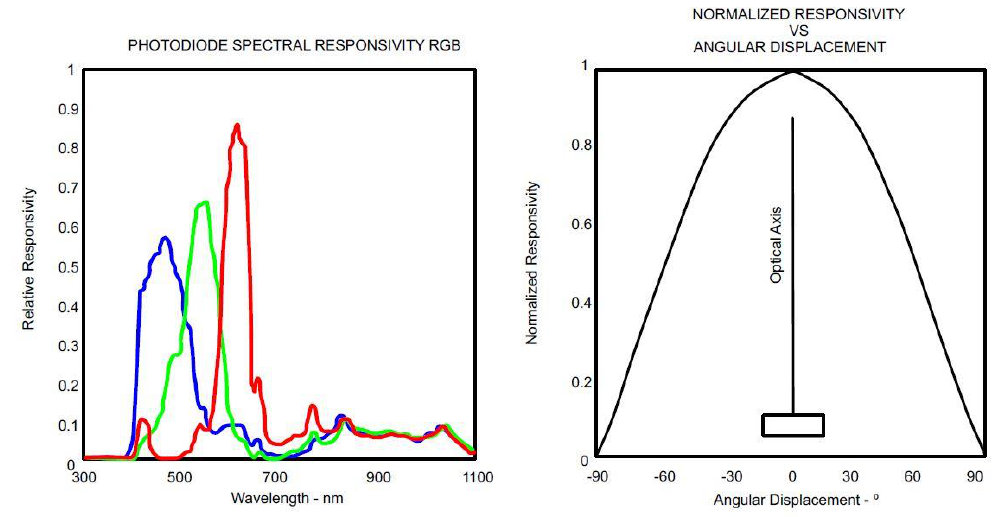
Figure 1. TCS3472 sensor responsivity graphs ( a , b )